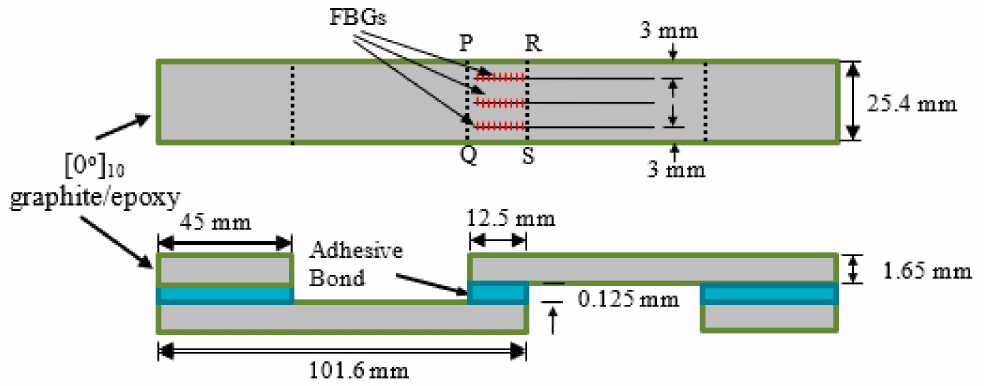
Figure 2. Dimensions and layout of the single-lap joint